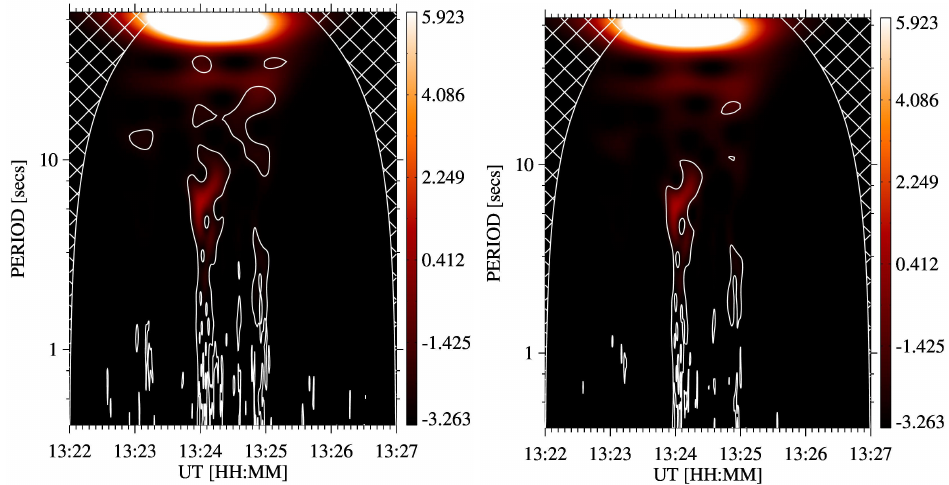
Figure 6. The wavelet power spectrum for the radio flux detected at 3GHz in the 13:22–13:27UT time interval with the overplotted significance levels (white lines) set to 95% ( left panel) and 99% ( right